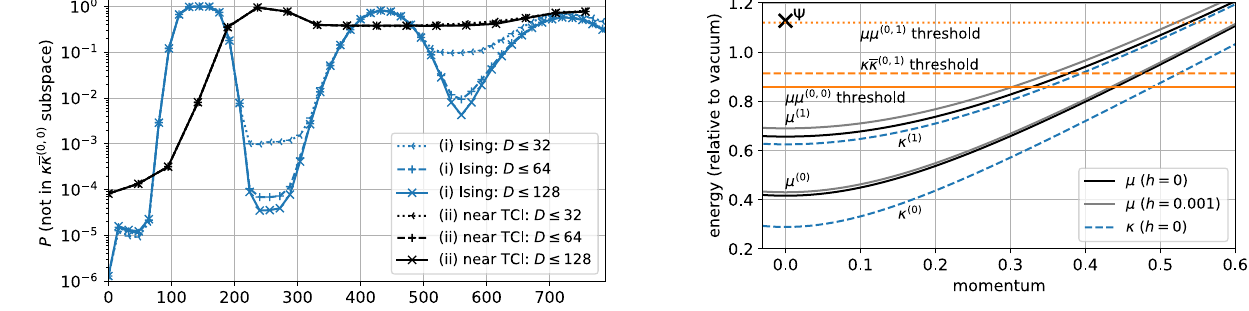
FIG. 8. Portion of state (by probability) outside of the MPS kink-antikink subspace κκ ( 0,0 ) for simulations (i) and (ii) of Fig. 7. Here we fully account for momentum dependence of the basis states | κκ j , k (cid:3) via a Fourier analysis and count only contribu- tions with k − j ≥ 60 (see Appendix D). For Ising (i), the small probability after the first collision of t ≈ 140 indicates elastic scattering of kinks, in stark contrast with the TCI case (ii), where the probability remains high after the first collision at t ≈ 250. In (i), the growth of the postcollision probability with subsequent collisions is consistent with delocalization of the wavepackets, since contributions from kink-antikink pairs with k − j < 60 are not counted. Hence, the larger values for (i) after the second col- lision at t ≈ 430 should not be taken as evidence of inelastic scattering.